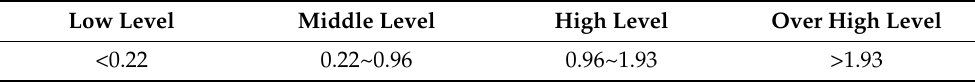
Table 2. Classification standard of UDI.